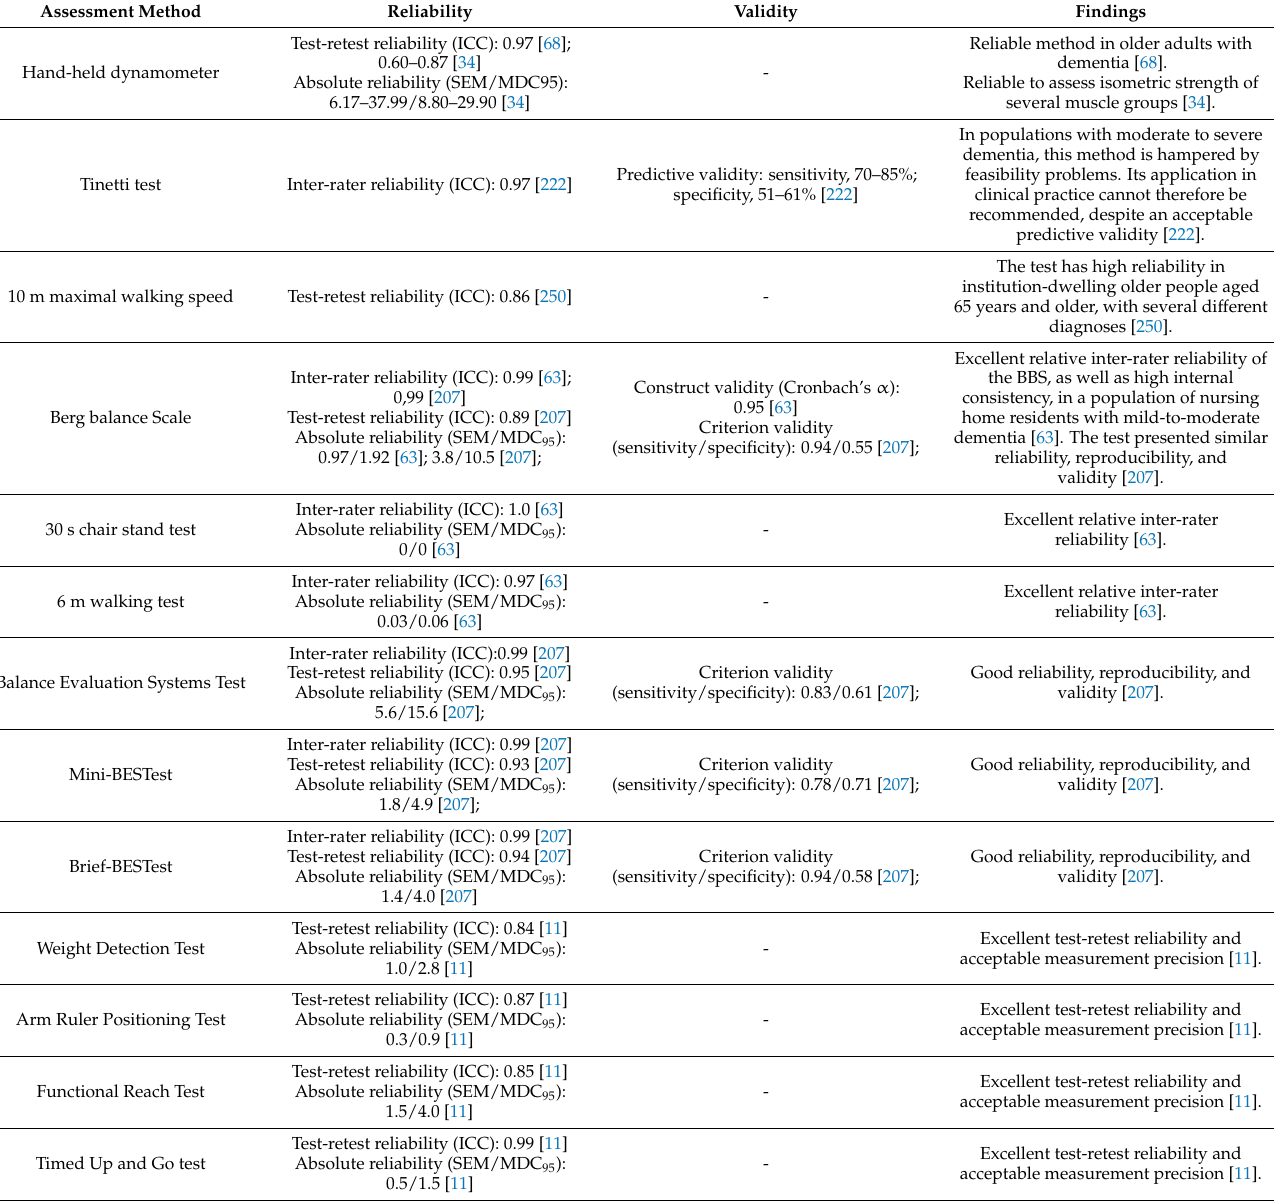
Table 5. Reliability, validity, and summary of the tests’ psychometric